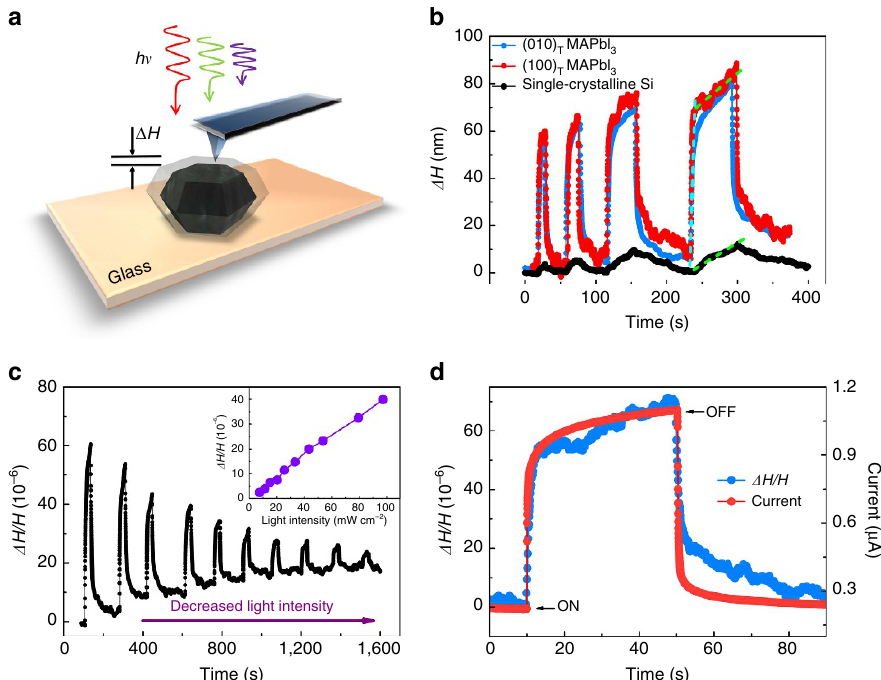
Figure 2 | Photostrictive effect of MAPbI 3 single crystals. ( a ) Schematic drawing of the experimental set-up for the photostrictive measurements. The AFM tip is fixed at one point on the sample to record the height as a function of time. ( b ) Photostriction in the MAPbI 3 single crystal. Both (100) T - and (010) T -oriented single crystals produce a similar elongation of B 50p.p.m. under 100mWcm (cid:3) 2 white-light illumination. The height change of a Si single crystal is also measured as a comparison. Cyan and green dash lines delineate the fast and slow components of the height change, respectively. ( c ) Light intensity dependence of the photostrictive effect. The inset shows the proportional relationship between the photostriction and light intensity. ( d ) A comparison between the height and current changes on light irradiation.